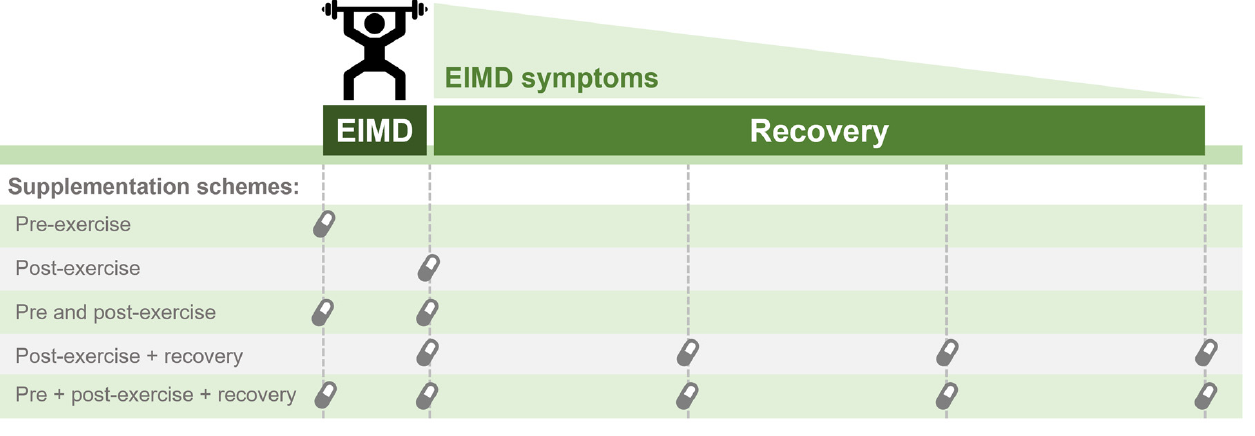
Figure 3. Representation of possible supplementation schemes to counteract exercise-induced muscle damage (EIMD) symptoms or accelerate recovery after